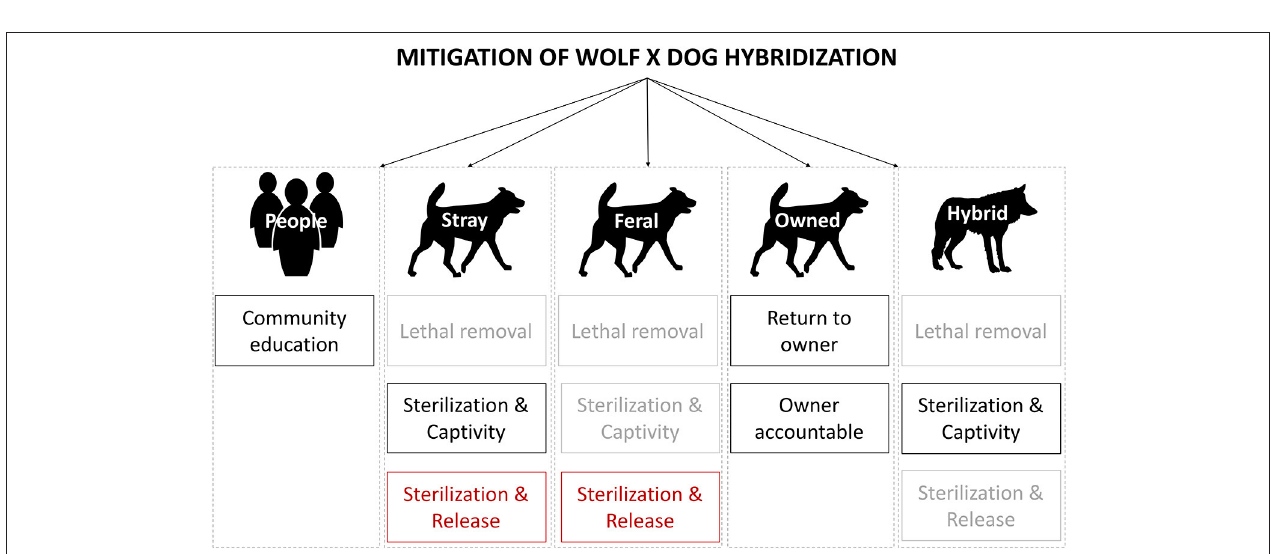
FIGURE 5 | Visual representation of management interventions to mitigate wolf × dog hybridization, explored in a Delphi study with a group of selected experts ( n = 42). Management approaches on which experts’ consensus (i.e., at least 27/42 experts agreeing) was reached are outlined in black. Consensus was reached against the management approaches that are outlined in red. Approaches that are faded-in did not reach consensus, and deserve particular emphasis in discussions and symposium settings, to aid effective